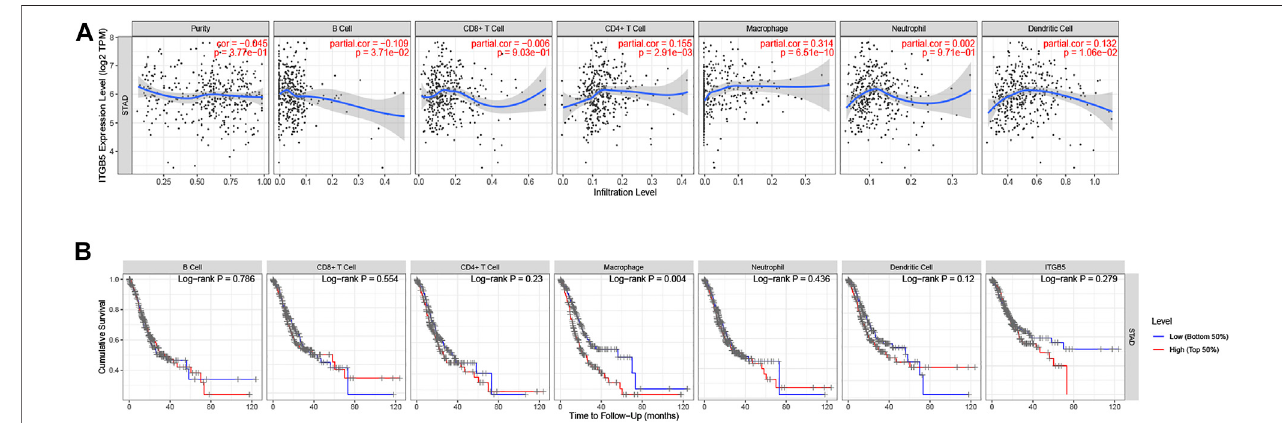
FIGURE 12 | Immune correlation analysis of ITGB5 based on immune in fi ltration in GC. (A) Correlation of ITGB5 expression with immune cell in fi ltration. (B) Prognostic value of immune cell in fi ltration in GC.